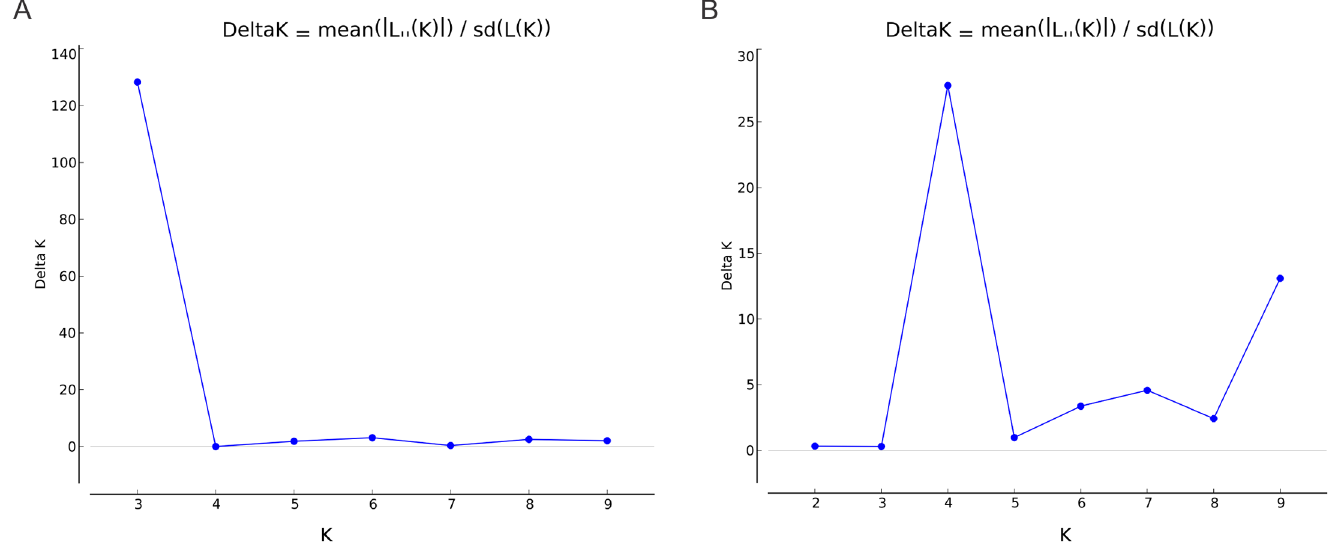
Fig 3. Number of populations using in the STRUCTURE analysis calculated according to [35]. The results presenting in (A) show three populations in the Brazilian Cryptococcus gattii VGII and in (B) show four populations in the STs identified in different countries previously published and in